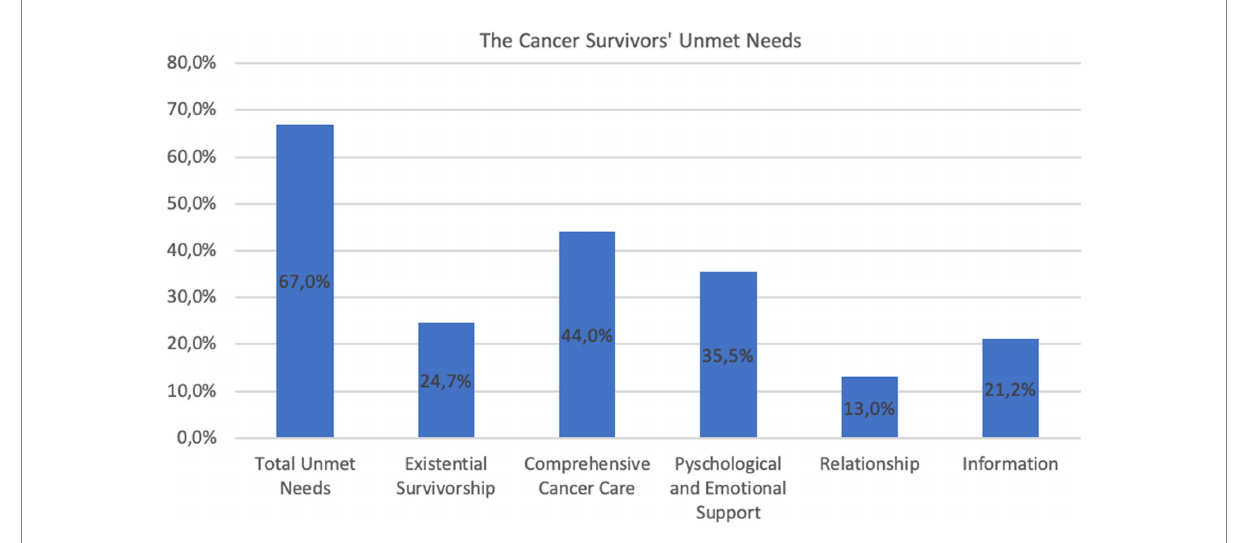
FIGURE 2 The prevalence of the total unmet needs and the unmet needs in each specific domain.